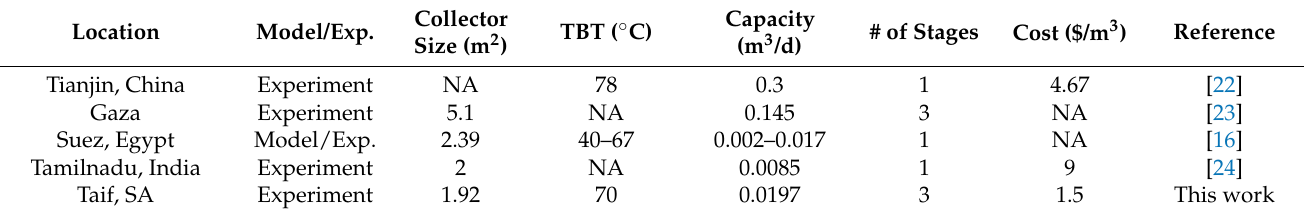
Table 5. Comparison of major